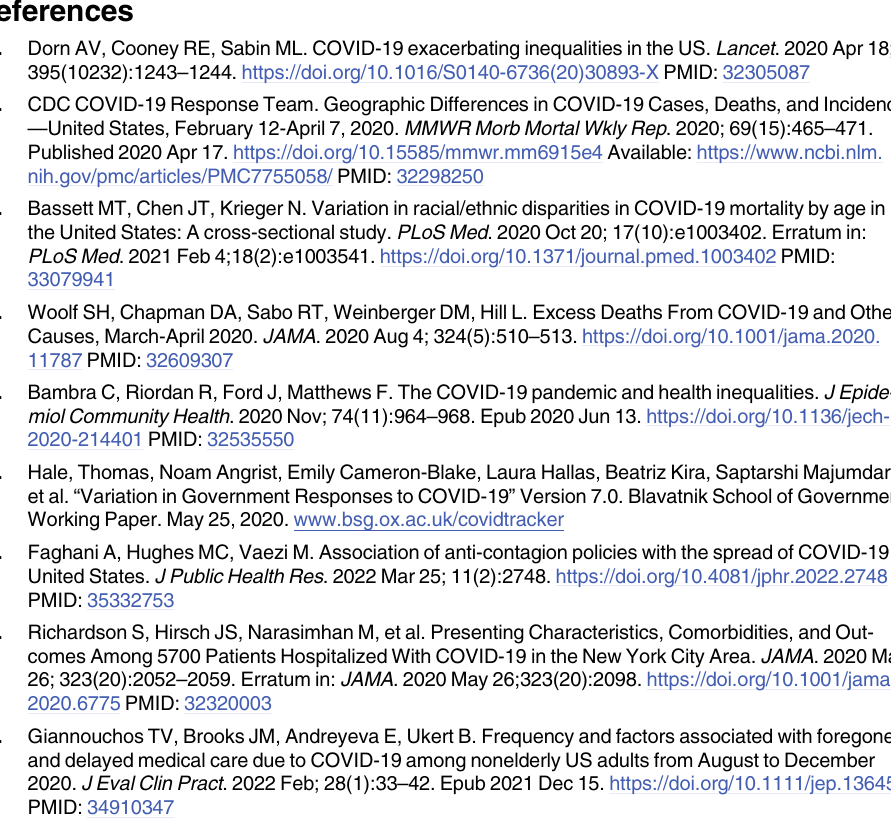
S4 Table. EQ-5D-5L, level sum score, and EQ VAS, univariable and multivariable analysis in healthy and diseased